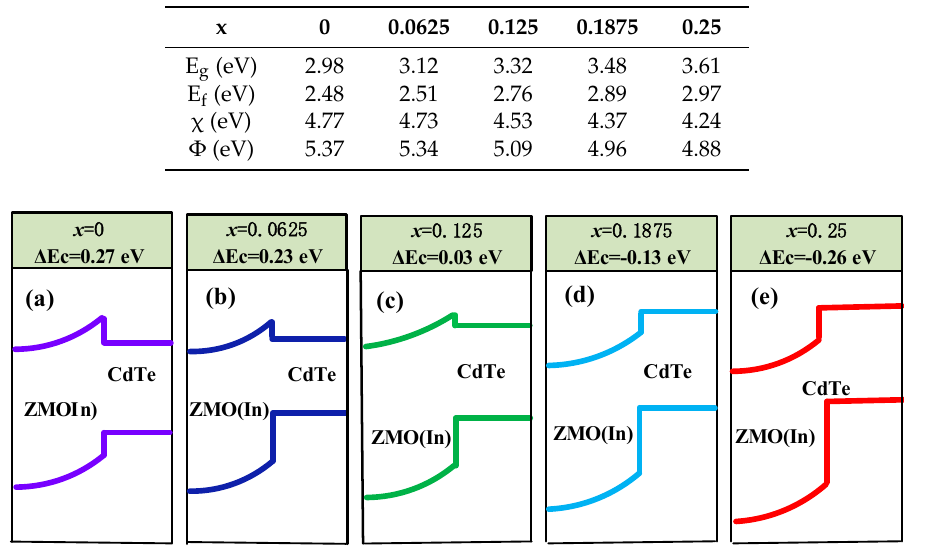
Figure 7. Schematic energy band diagram of ZMO:In/CdTe Layers. ( a ) x = 0; ( b ) x = 0.0625; ( c ) x = 0.125; ( d ) x = 0.1875 and ( e ) x = 0.25.